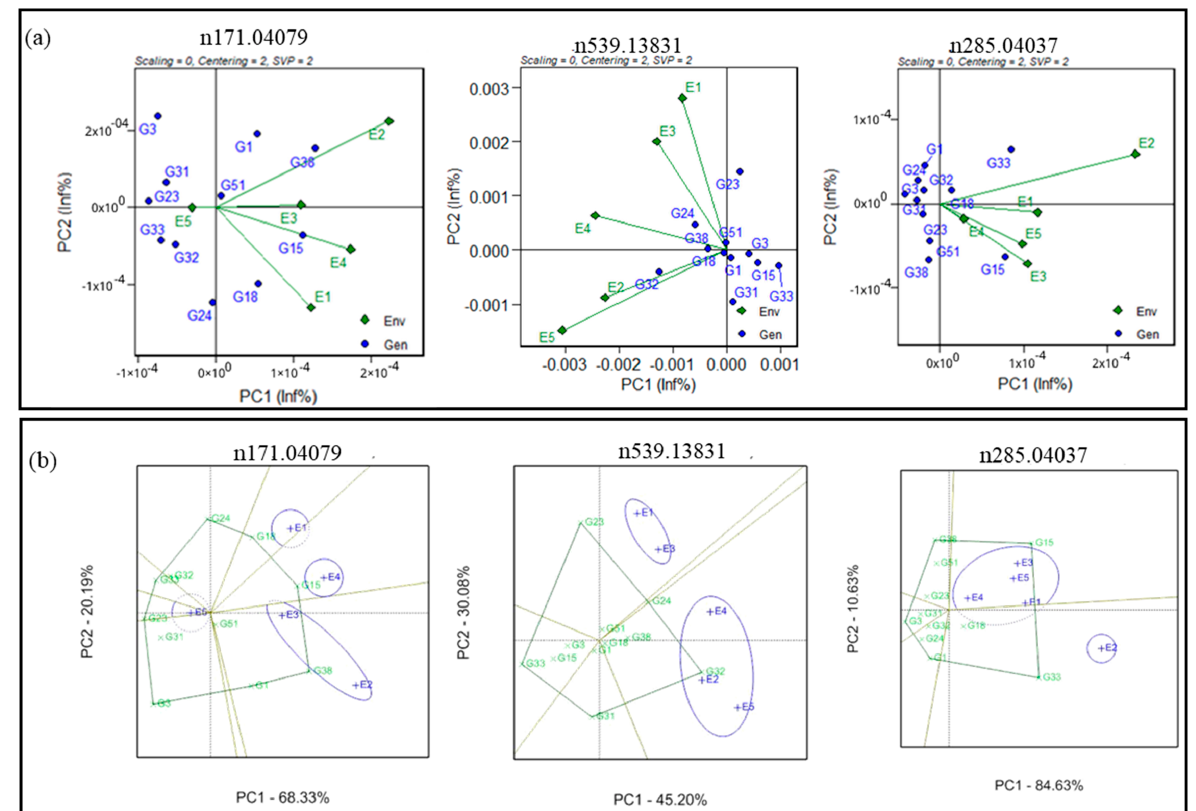
Figure 3. Genotype-by-genotype x environment (GGE) biplot ( a ) to identify the favourable environ- ment for antioxidant- (n171.04079), starch- (n539.13831), and vitamin- (n285.04037) linked metabo- lites and ( b ) polygon view biplot for identification of stable genotypes for antioxidant- (n171.04079), starch- (n539.13831), and vitamin- (n285.04037) associated metabolites across the testing environ- ments.